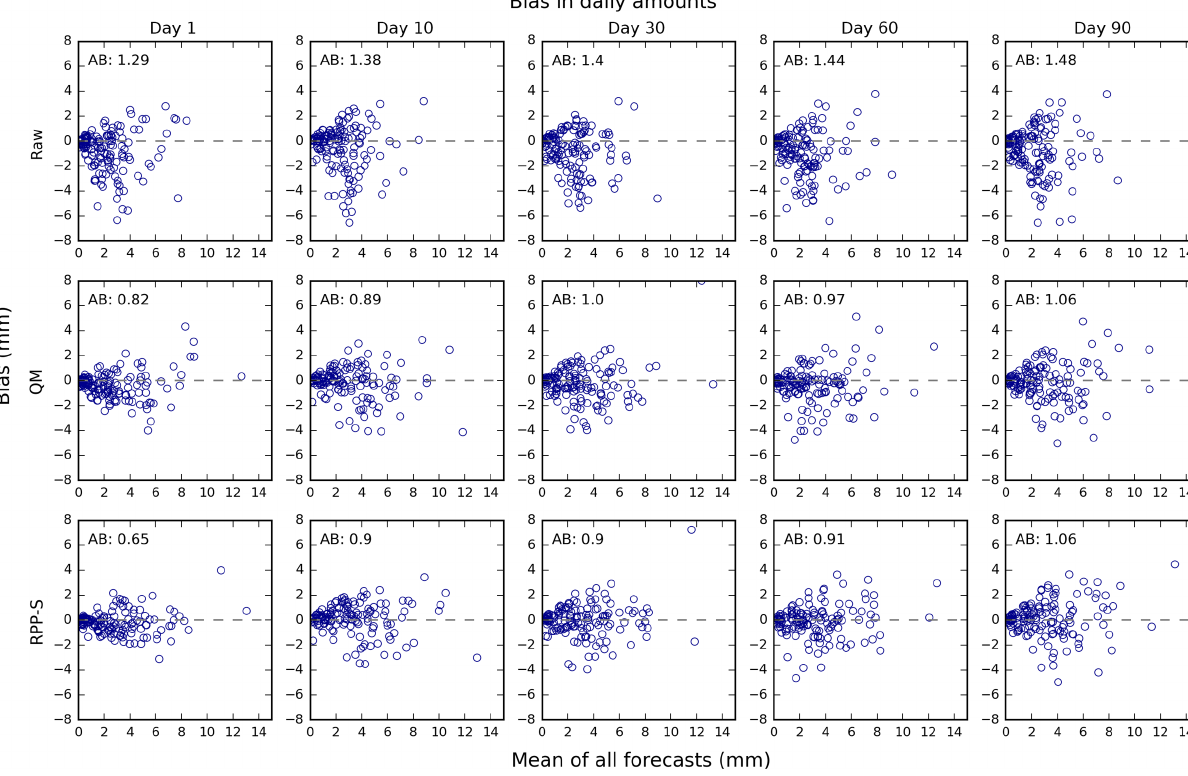
Figure 3. Bias in daily rainfall forecasts for raw, QM and RPP forecasts (rows) and selected days ahead/lead times (columns). The scatterplots are of forecast mean over all events ( x axis) versus bias ( y axis). There is one blue circle for each catchment and forecast initialisation time. The average absolute bias (AB) is printed in the top left